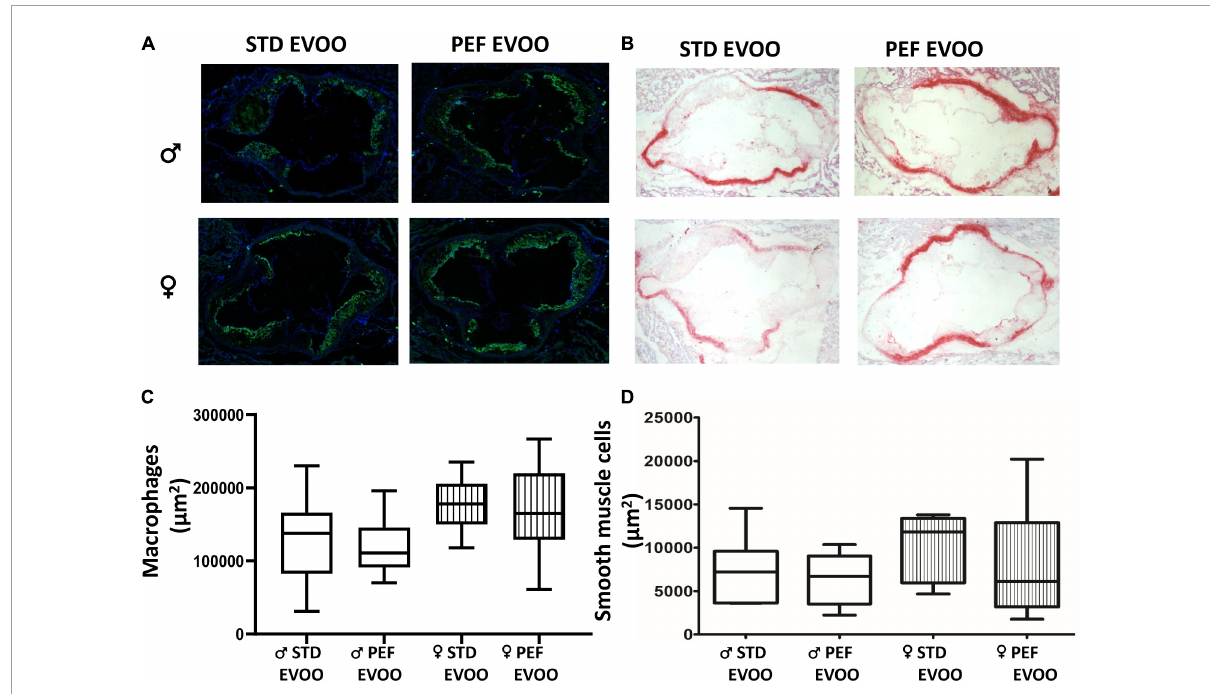
FIGURE3 Effect of EVOO extraction procedure on atherosclerotic plaque characteristics in Apoe -KO mice after the dietary intervention. Representative aortic images corresponding to immunofluorescence detection of CD68 macrophages (A) and α -ACTIN detection of smooth muscle cells (B) . Quantification of macrophages as CD68 staining area ( µ m 2 ) (C) and α -ACTIN surface staining as µ m 2 (D) . Results are shown as 5–95 percentiles for each group using empty boxes for males and striped boxes for females. Statistical analysis was carried out by Mann–Whitney’s- U